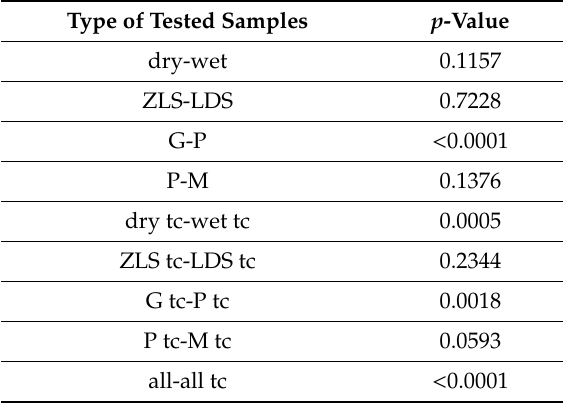
Table 1. p -values for the roughness variations of the tested